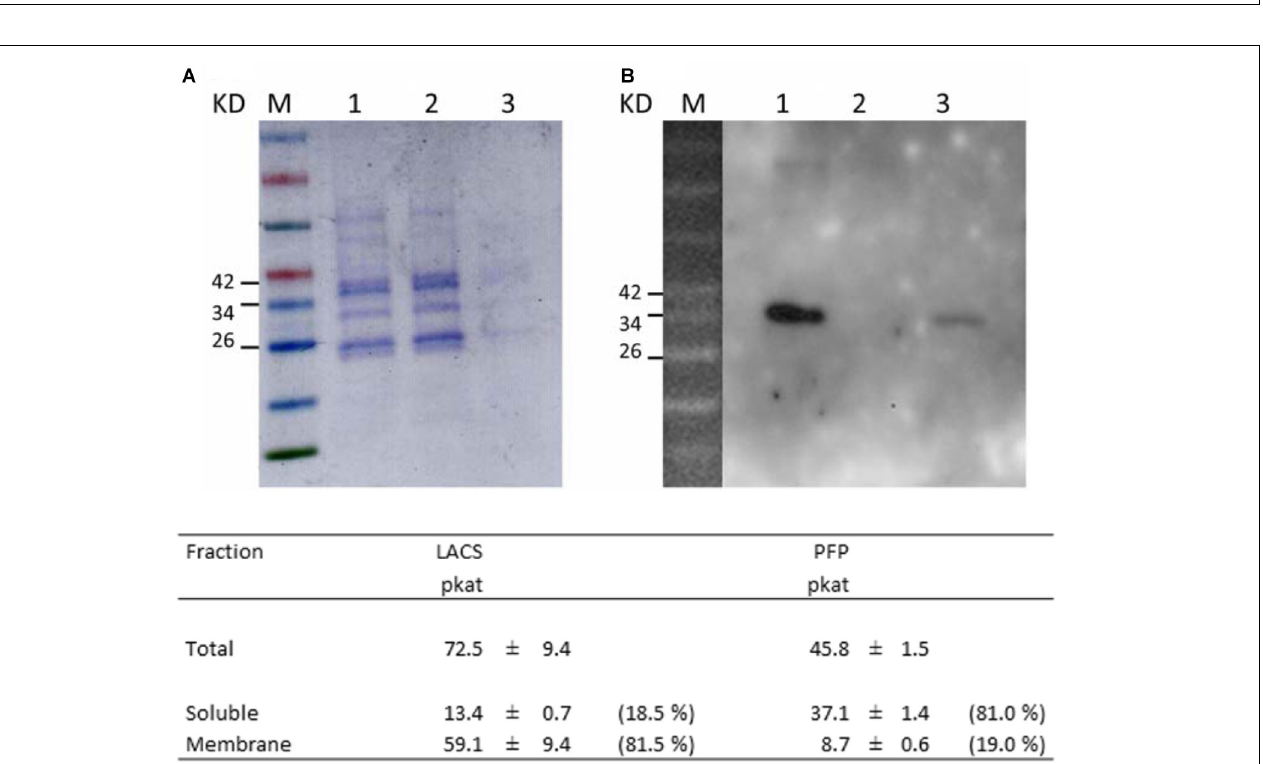
FIGURE 10 | Subcellular localization of Ha FatB in sunflower seed plastids. (A) SDS–PAGE protein gel stained with Coomassie blue of: the molecular weight markers (line M), total plastid protein (lane 1), soluble subcellular fraction (lane 2), and membrane fraction (lane 3). (B) Western blot probed with anti- At FatB antibodies showed that Ha FatB was in the total and membrane fractions. Results from biochemical assays to determinate the purity of the soluble and membrane fractions. LACS (long chain acyl-coA synthetase, membrane fraction control) in the total, soluble and membrane fractions of plastids was assayed to determine the purity of the soluble fraction. Pyrophosphate-dependent phosphofructokinase (PFP, soluble fraction control) in the total, soluble and membrane fraction of plastids was assessed to determine the purity of the membrane fraction. Data corresponded to the average of three determinations from different biological replicates plus minus SD.